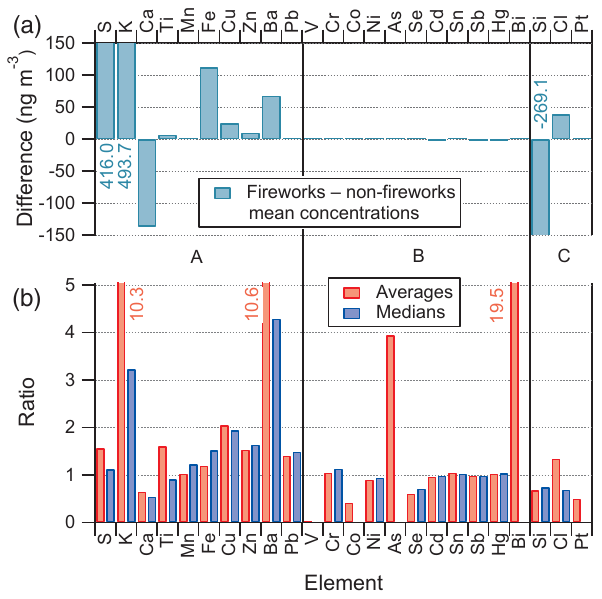
Figure 7. (a) Difference between average concentrations of fire- works and non-fireworks periods. Numbers indicate values outside the axis range for S, K, and Si (negative). (b) Enhancement ratios for all analysed elements for fireworks/non-fireworks classification, sorted by group. Numbers indicate values outside the axis range for S, K, and